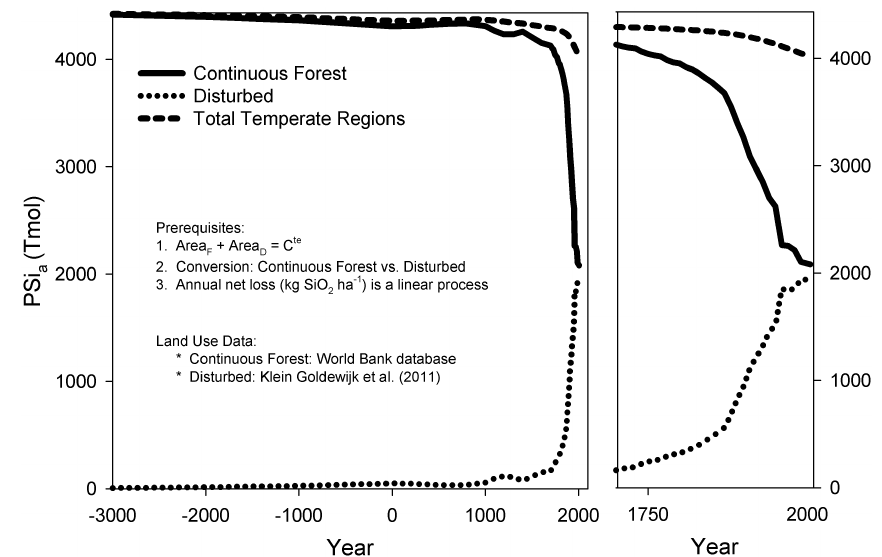
Fig. 5. Historical evolution (3000BCE–2005CE) of the amorphous silica pool (PSi a , Tmol) for continuous, disturbed and total land area in temperate soils.